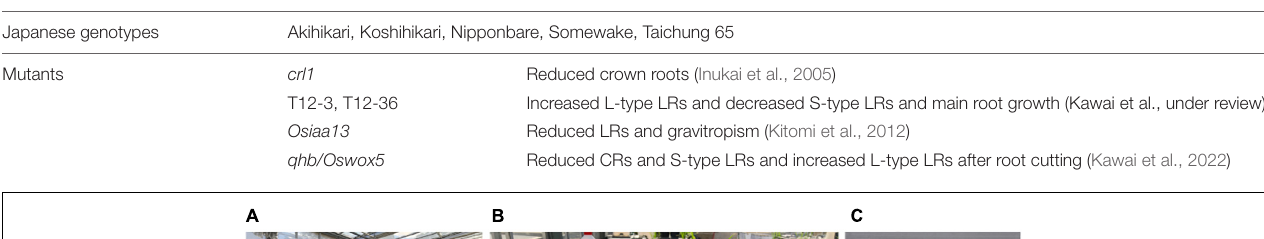
TABLE 1 | Rice genotypes used in this study.